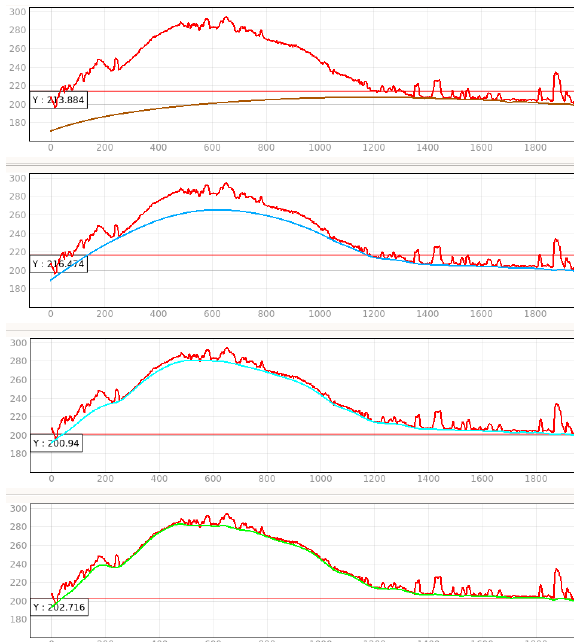
Figure 10. From Top to Bottom: Initial Cloth Simulation - Proposed Cloth Simulation with max object size = 64 - Proposed Cloth Simulation with max object size = 32 -